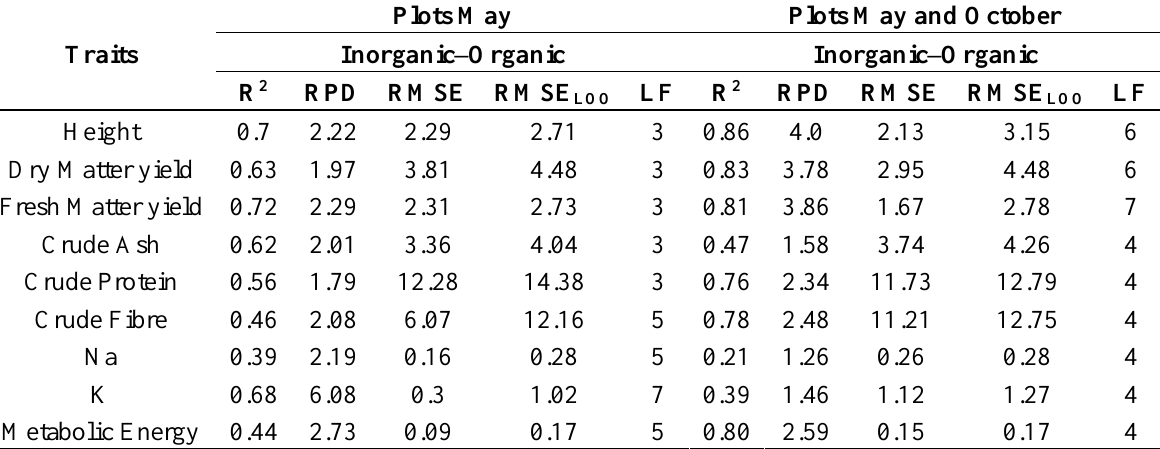
Table 7. Overview of the results for the partial least squares regression method of dataset investigation of the integrated sub-dataset of May and October and the sub-dataset of May, in both cases including all inorganic and organic levels of fertilization. (RPD: Residual Predictive Deviation; RMSE: Root Mean Square Error; RMSE LOO : Root Mean Square Error of the Leave-One-Out; LF: Latent